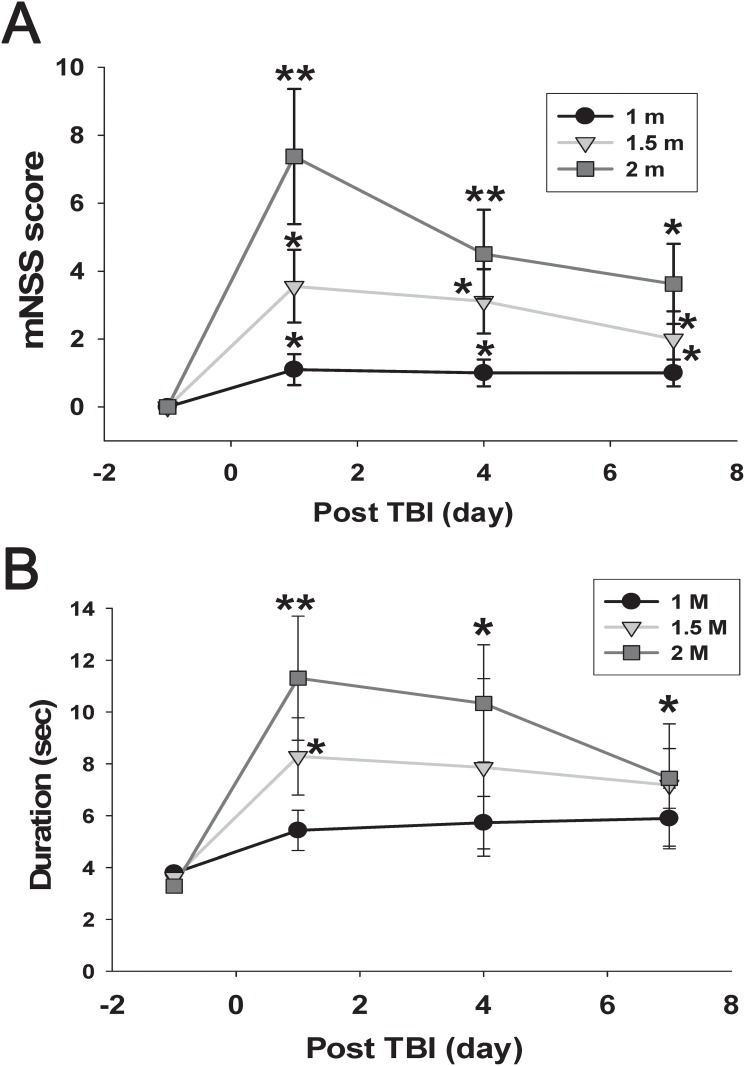
Neurological function evaluated using the mNSS to assess the initial disability before brain injury and on days 1, 4, and 7 following weight-drop-induced brain injury at various fall heights (A). The mNSS in 1, 1.5 and 2 m weight-drop group were persistently higher than that of pre-lesion baseline value after TBI over the complete 7-day observation period. Motor balance function was assessed using the beam walking test (B). Pre- and post-TBI mean ± SEM walking ability as measured by time (s) to traverse an elevated beam for various fall heights. The 2-m weight-drop group exhibited significant impairment on day 1 and remained consistent up to day 7 after the weight-drop lesion when compared with the pre-lesion baseline value. *p < 0.05, **p < 0.01 as compared to pre-operative values (n = 10 in 1-m weight-drop group, n = 9 in 1.5-m weight-drop group, n = 6 in 2-m weight-drop group).